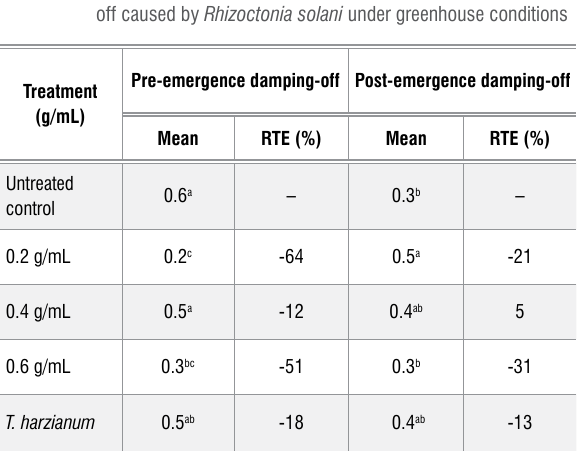
Comparing the effect of Moringa oleifera extract and Trichoderma harzianum on pre- and post-emergence damping- off caused by Rhizoctonia solani under greenhouse